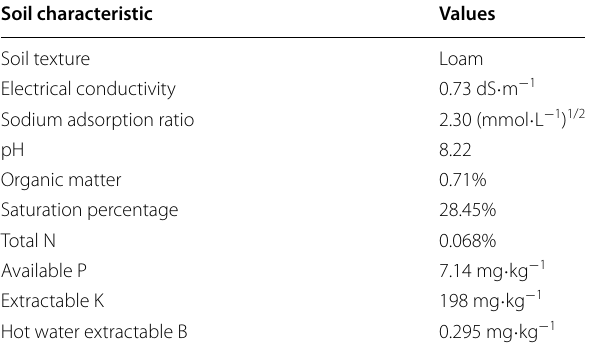
Table 1 Pre-sowing analysis of experimental soil Soil